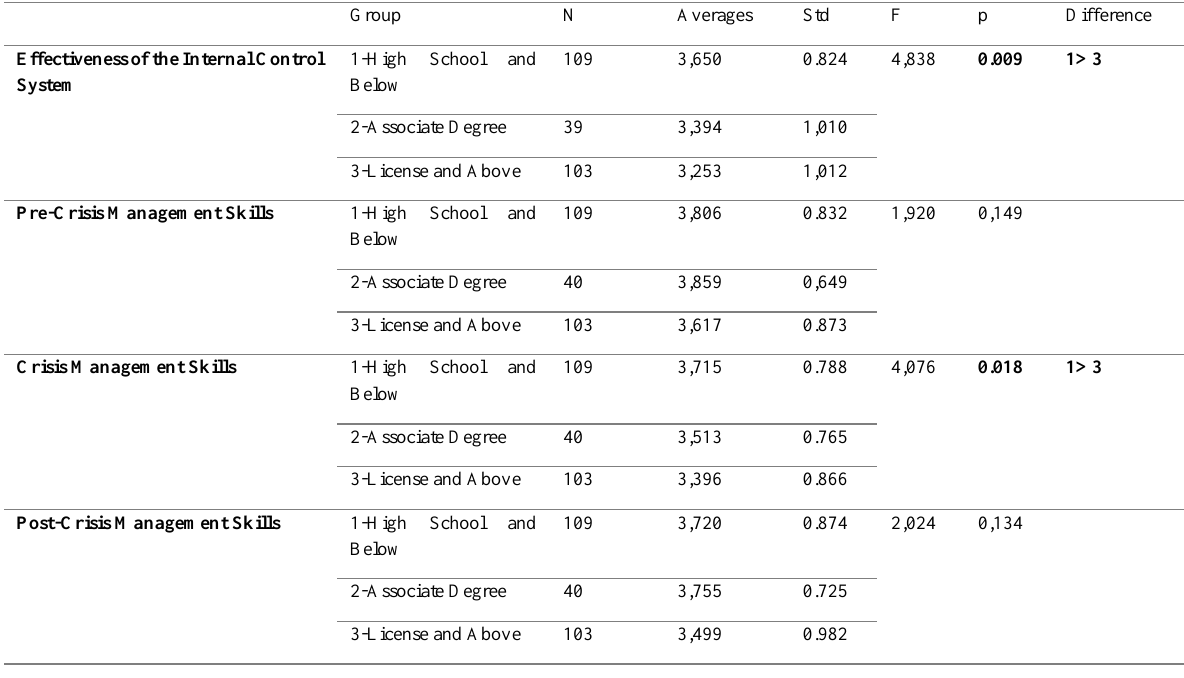
Table 10: ANOVA Differentiation Status of Participants' Effectiveness of Internal Control System and Crisis Management Skill Scores